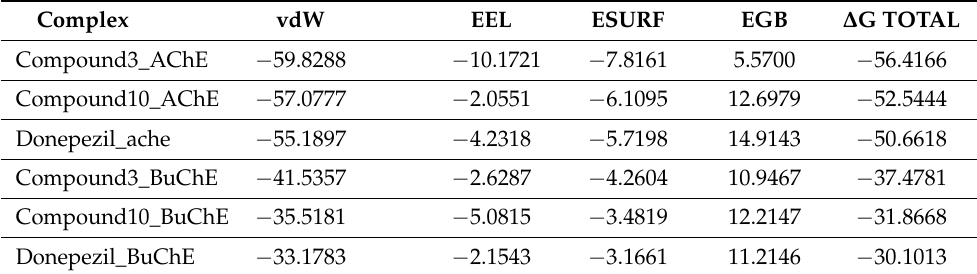
Table 2. MMGBSA analysis. All units are reported in kcal/mole .